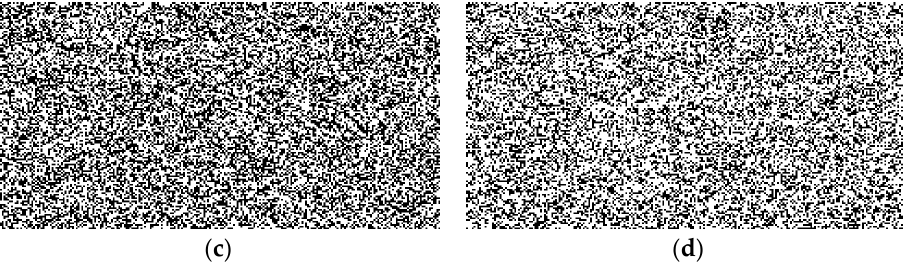
Figure 17. Restored Black &White Data Image ( a ) Image 1, ( b ) Image2, ( c ) Image 3, ( d ) Image 4.